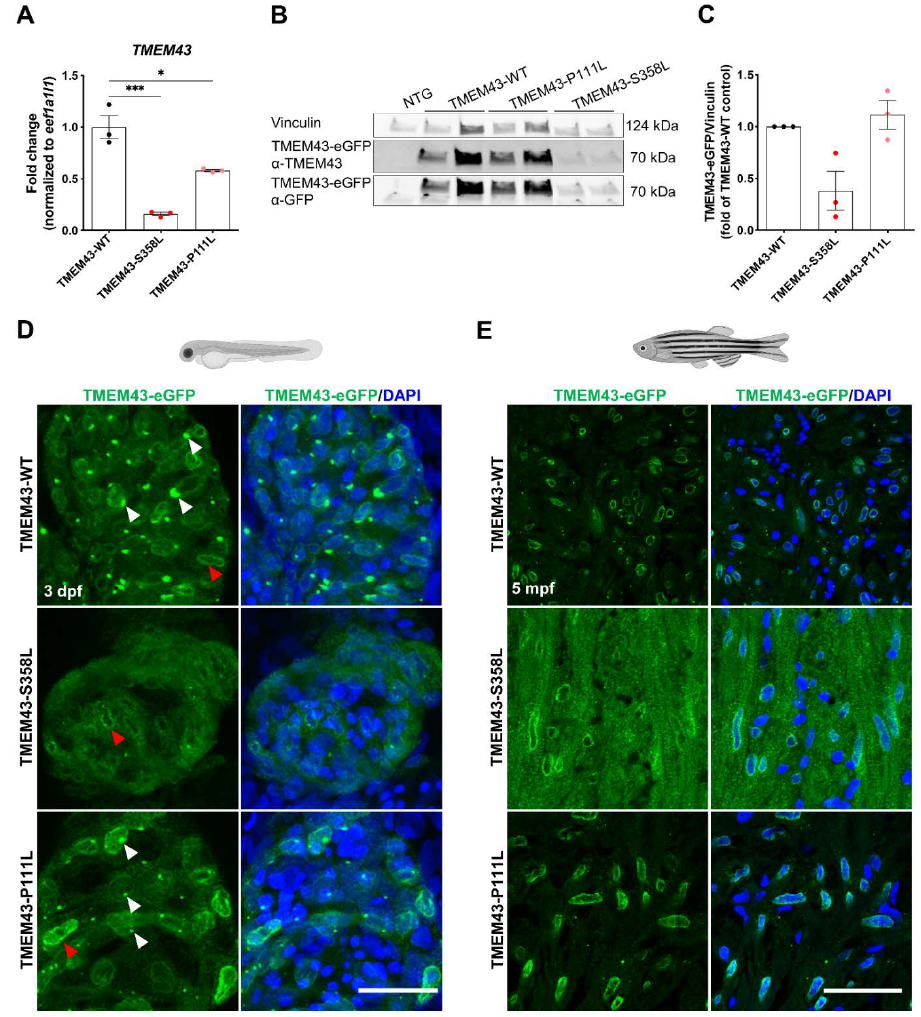
Figure 2. Reduced expression and altered localization of TMEM43-p.S358L. ( A ) Quantitative reverse transcription PCR demonstrates transcript reduction in human TMEM43 in adult ventricles of both TMEM43 variant transgenic lines compared to wild-type (WT). Each replicate consists of a pool of 2–7 ventricles and relative expression is calculated to TMEM43-WT expression levels. ( B ) Repre- sentative Western blot showing reduced occurrence of the human TMEM43-eGFP fusion-protein in adult ventricles of TMEM43-S358L compared to the TMEM43-WT transgenic line. For detection, both a TMEM43- and a GFP-antibody were used. Each biological replicate consists of a pool of 1–4 ventricles. ( C ) Western blot analysis using the TMEM43-antibody showed a reduced protein level of the human TMEM43-eGFP fusion-protein in adult ventricles of TMEM43-S358L compared to the TMEM43-WT transgenic line. Each data point represents relative Western blot band intensity of a technical replicate. ( A , C ) One-way ANOVA with Bonferroni’s multiple comparison test, * p ≤ 0.05, *** p ≤ 0.001. Error bars correspond to SEM. ( D ) Confocal images of whole-mount immunofluores- cence staining of hearts expressing the transgene TMEM43-eGFP (green) at 3 days post-fertilization (dpf). Note the TMEM43-WT expression at the nuclear membrane and the endoplasmic reticulum (ER). TMEM43-S358L displays a weak signal at the nuclear membrane, but no signal at the ER. White arrowheads indicate TMEM43-eGFP localization at the ER, red arrowheads indicate localization at the nuclear membrane. Scale bar = 30 µ m. ( E ) Confocal images of immuno-stained paraffin sections of 5 months post fertilization (mpf) dissected hearts expressing the transgene TMEM43-eGFP (green). Scale bar = 30 µ m. Created with BioRender.com (accessed on 13 August